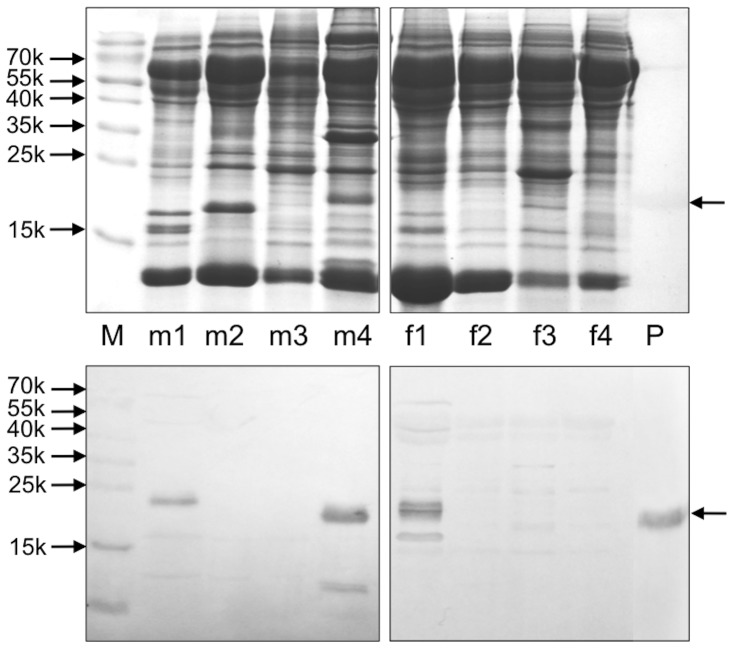
Expression of rabOBP3 in different tissues of male (m) and female (f) rabbit individuals.SDS-PAGE analysis of different rabbit tissues and corresponding Western blotting are shown. M: molecular weight markers; m1: nasal respiratory tissue; m2: epidydimis; m3: testis; m4: prostate; f1: nasal respiratory tissue; f2: uterine tubes; f3: ovaries; f4: uterus; P: purified rabOBP3.